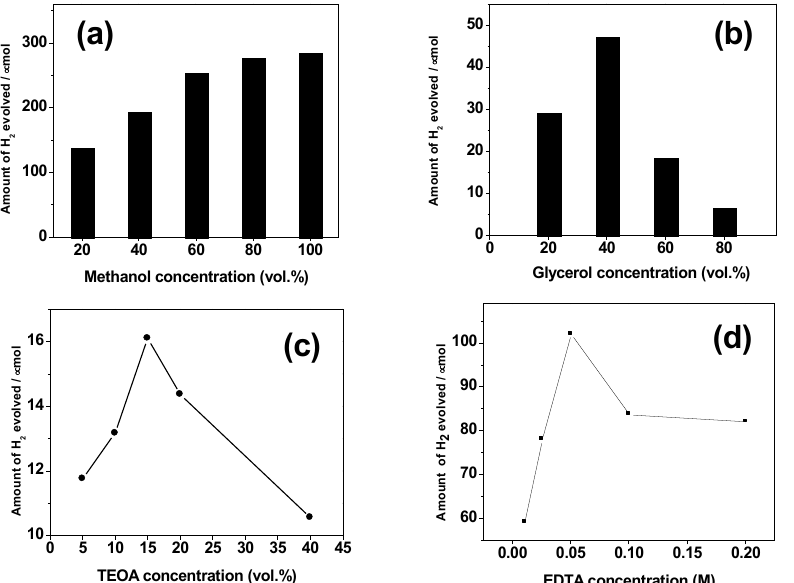
Figure 5. The effects of type and concentration of electron donors on the photocatalytic hydrogen evolution activity over 1.5% CuO ‐ SrTiO 3 : ( a ) methanol, ( b ) glycerol, ( c ) TEOA and ( d ) EDTA. The amount of catalyst: 60 mg; volume of reaction solution: 60 mL; reaction temperature: 25 °C; irradiation time: 2 h.